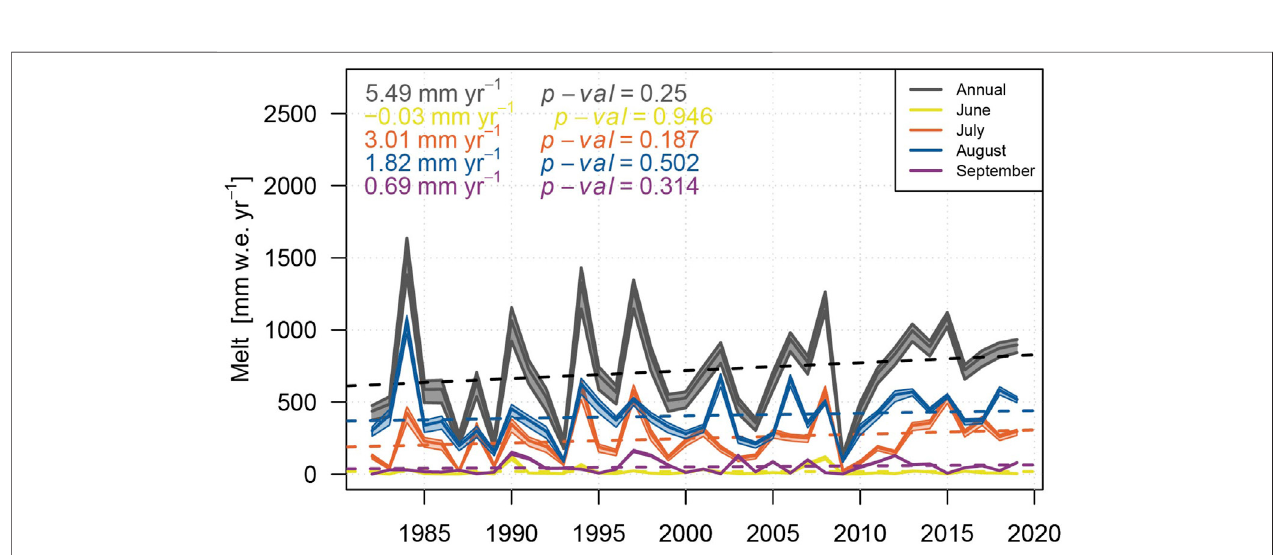
FIGURE 12 | Modelled glacier melt in the Big Naryn catchment normalized by glacier area (plain lines) and linear trends (dashed lines).